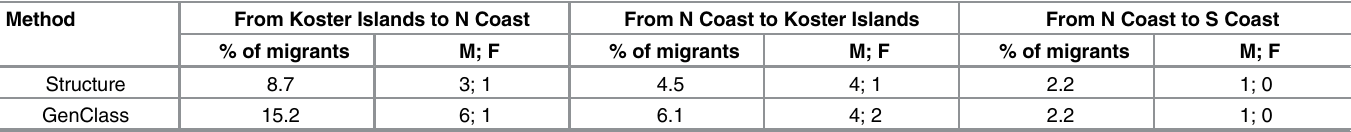
Table 3. The proportion of migrants and the number of males and females dispersed between sites. M – males; F – females. Information about sex was not available for all collected mink samples.